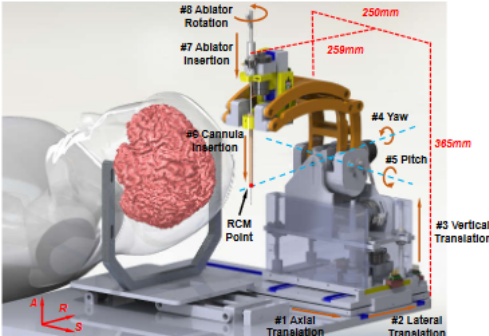
Figure 19. Li et al. 8-DoF system for brain tumor ablation using MR-tracking coils